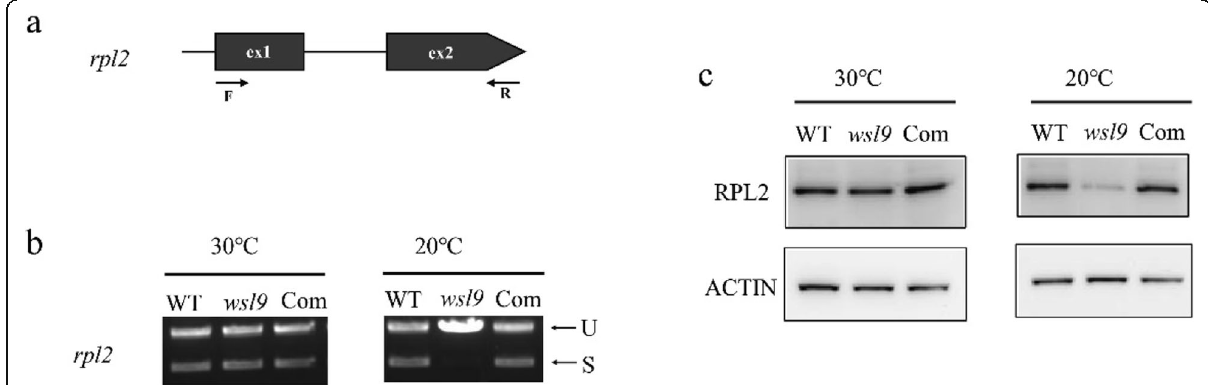
Fig. 8 Splicing analyses of rpl2 in WT, wsl9 and complemented transgenic plants. a Structure of the rpl2 gene. b RT-PCR analyses of rpl2 transcripts in WT, wsl9 and complemented transgenic plant under different temperature. Spliced (S) and unspliced (U) transcripts are indicated at the right. c Total leaf proteins were analyzed by probing immunoblots with RPL2-specific antiserum. The same amount was immunoblotted with ACTIN antibodies